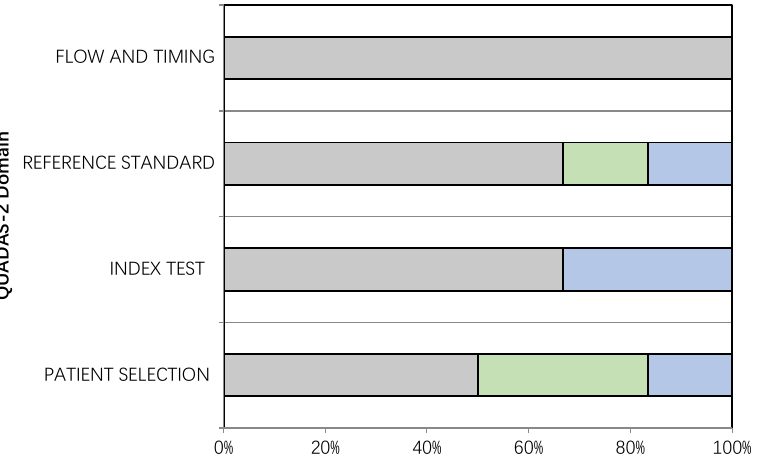
Figure 2. Overall Quality Assessment of the Studies Included in the Systematic Review, According to the QUADAS-2 Tool.